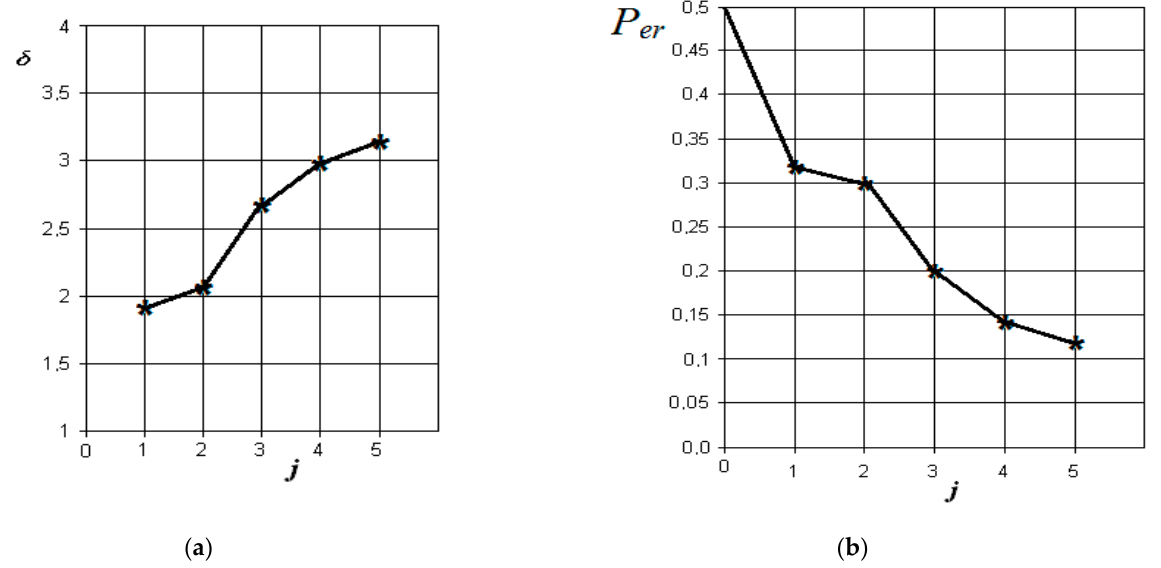
Figure 8. Results of discriminant analysis of data when comparing the norm with chronic odontogenic sinusitis: ( a ) dependence of the increase in the normalized Euclidean distance as signs are added to the discrimination model δ = f ( j ) ; ( b ) -the dependence of the decrease in the probability of error in decision-making as features are added to the P f(j) : j = 5 ‐ is the dimension of the space of informative parameters.